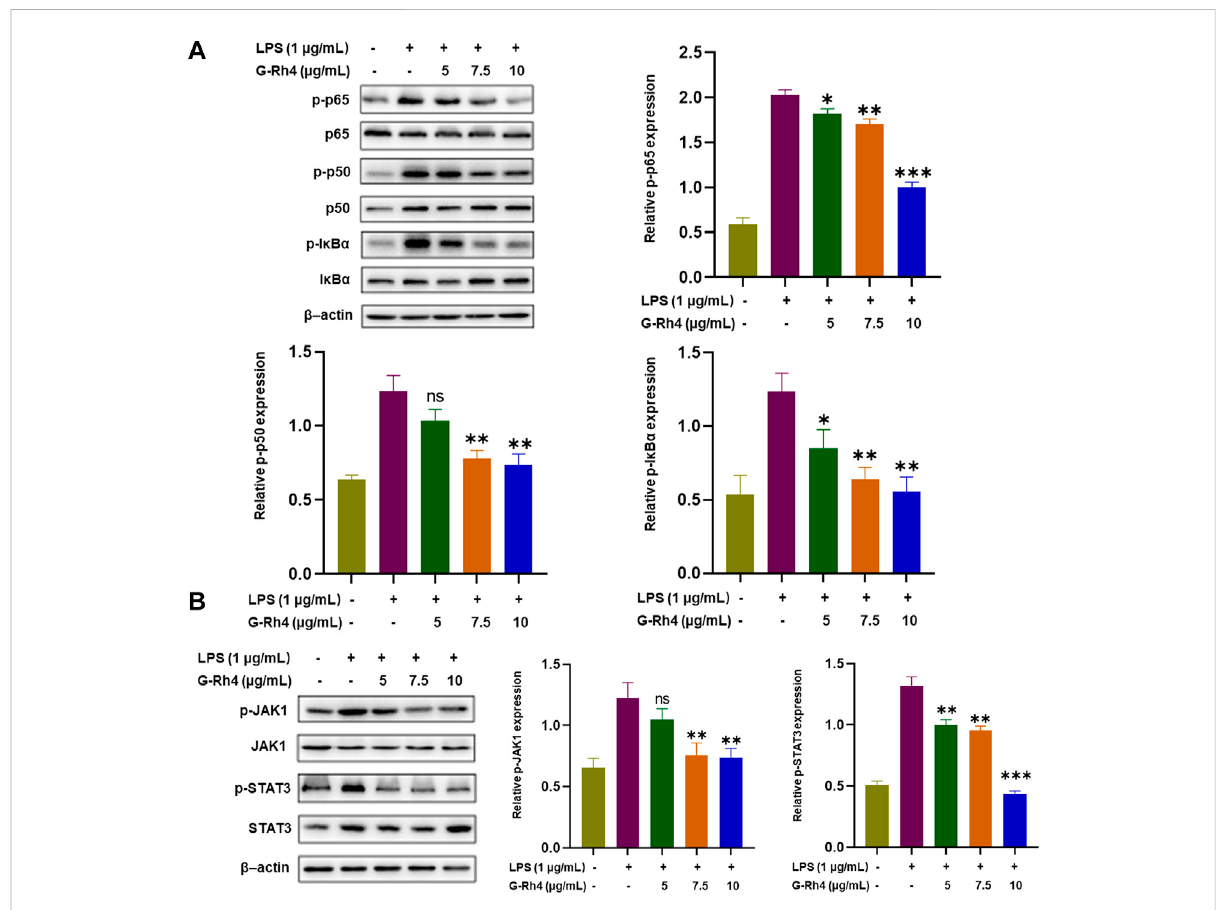
FIGURE 6 Effect of G-Rh4 on the NF- κ B and STAT-3 activation in RAW264.7 cells. (A) Determination of the p-I κ B α (Ser32), p-p65 (ser536), and p-p50 (ser337) protein using Western blot analysis. (B) Effect of G-Rh4 on the STAT-3 activation in RAW264.7 cells. Data were presented as the mean ± SD values performed in triplicate (* p < 0.05, ** p < 0.01, *** p < 0.001 vs. LPS